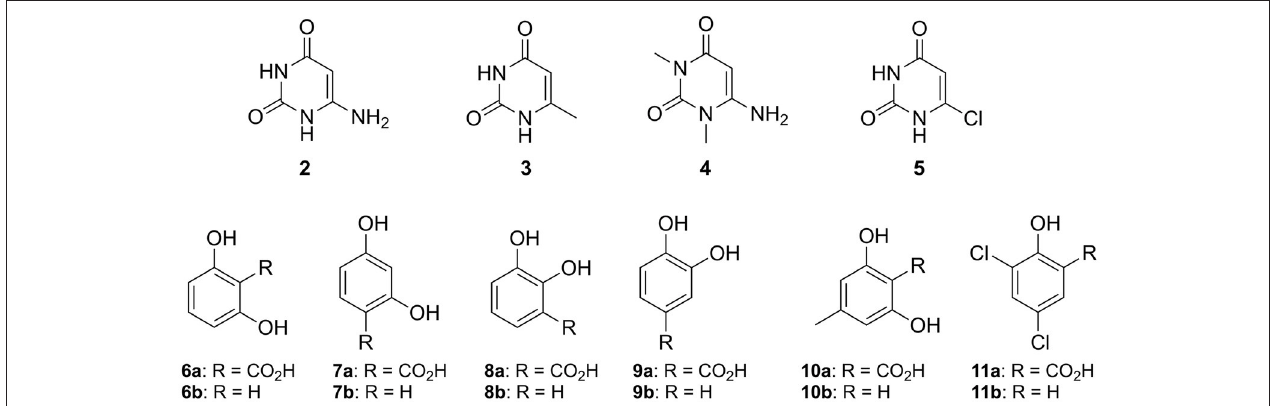
FIGURE 4 | Non-natural substrates for activity screening of IDCase: Pyrimidine derivatives (2–5) for carboxylation and phenolic carboxylic acids (6a − 11a) and phenols (6b − 11b) for decarboxylation and carboxylation, respectively.